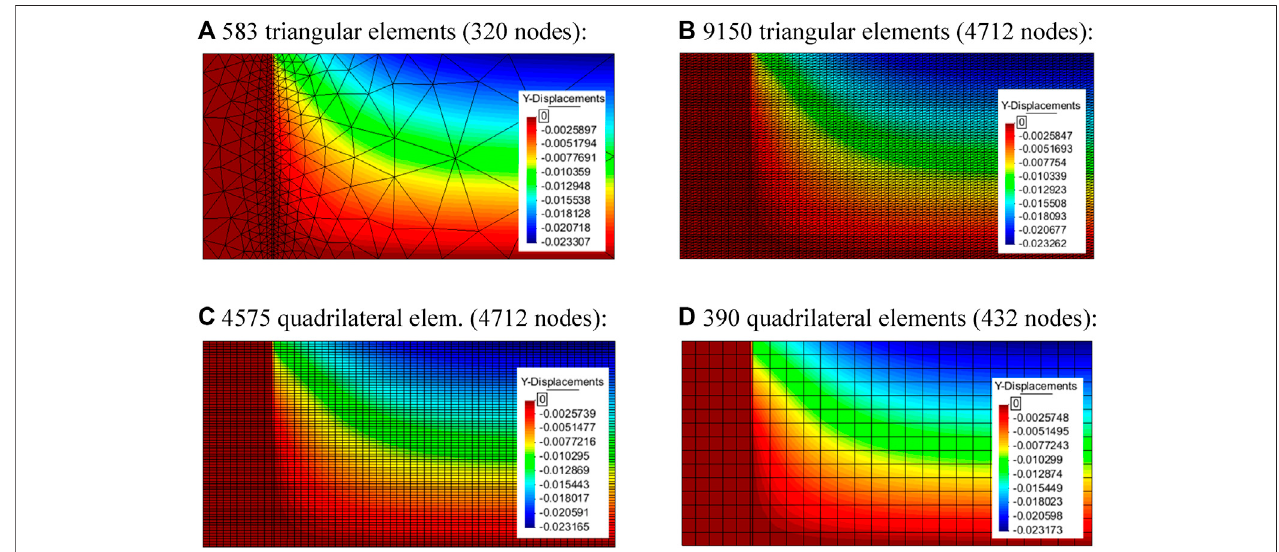
FIGURE 8 | Settlements results (units in meters) using program CODE_BRIGHT with q = 100-kPa surcharge for the different meshes assumed: (A) unstructured mesh with triangular elements, (B) triangular structured-mesh, (C) quadrilateral structured- fi ne-mesh, and (D) and quadrilateral structured-coarse-mesh. Cases with ti = 0.018 m and Ri =